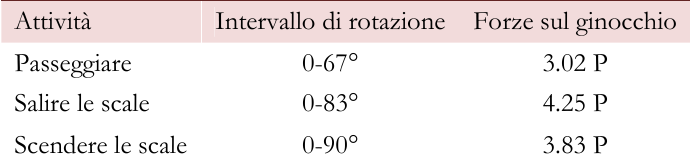
Table 1: Angle ranges for usual activities and typical values of force on the knee (P= body weight).